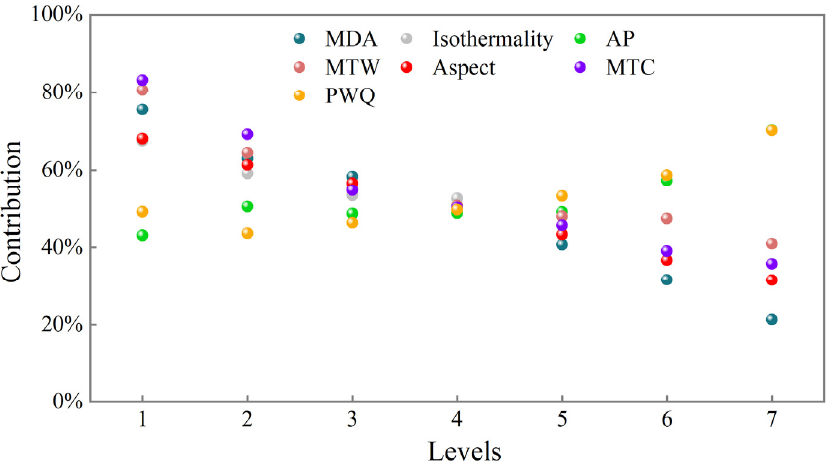
Figure 10. Internal hierarchical contribution diagram of di ff erent driving forces.